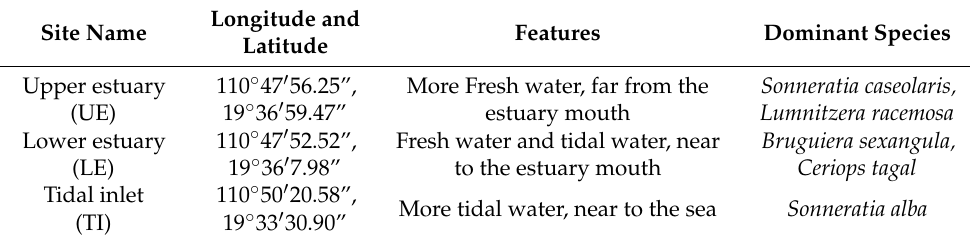
Table 1. Site description in different geomorphological